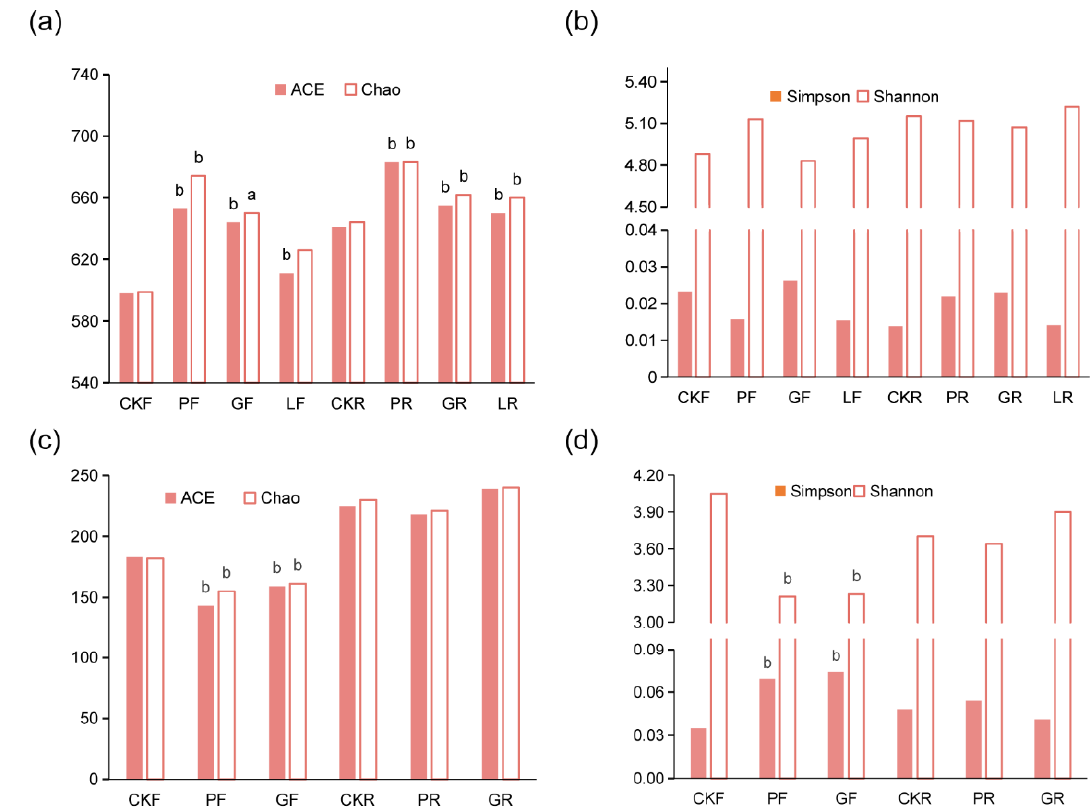
Figure 3. Diversity index of bacterial and fungal microbiome in the rumen and feces of dairy cows under different treatments. ( a ) ACE index and Chao index of bacterial microbiome, ( b ) Shannon index and Simpson index of bacterial microbiome, ( c ) ACE index and Chao index of fungal microbiome, ( d ) Shannon index and Simpson index of fungal microbiome. F: feces samples. R: rumen samples. a: Compared with the control group, p < 0.05, b: Compared with the control group, p < 0.01.